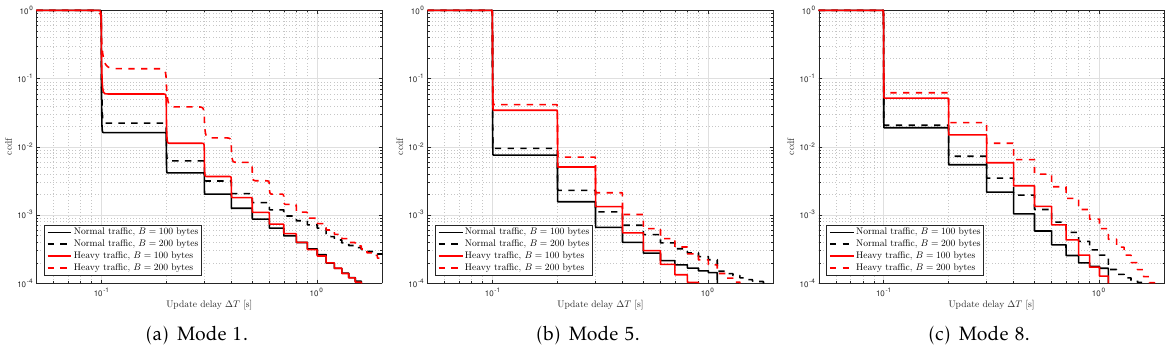
Figure 3. LOS ccdf of the update delay of the information from neighbors within a distance of 50 m for selected Modes.